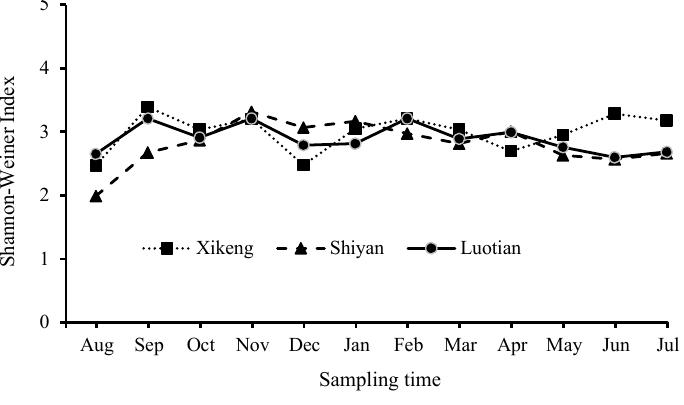
Figure 6. Shannon-Weiner index of three reservoirs.